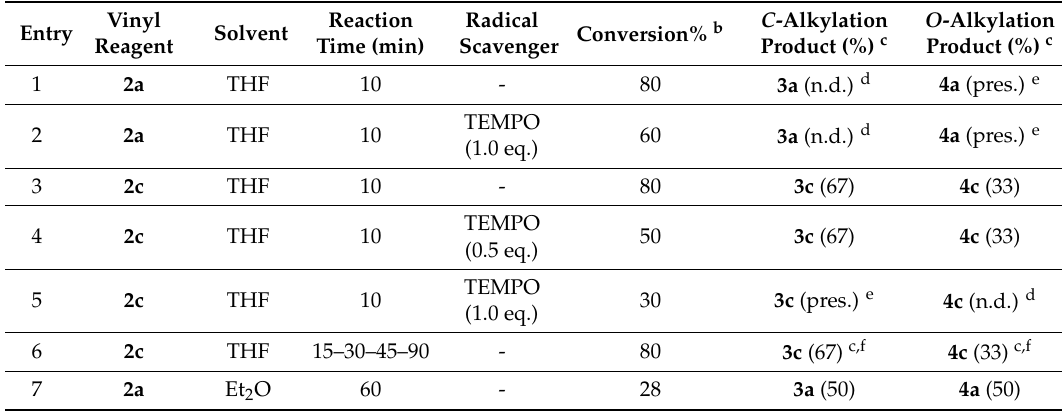
Table 2. Reactions of 1 with 2a and 2c under different experimental conditions. a